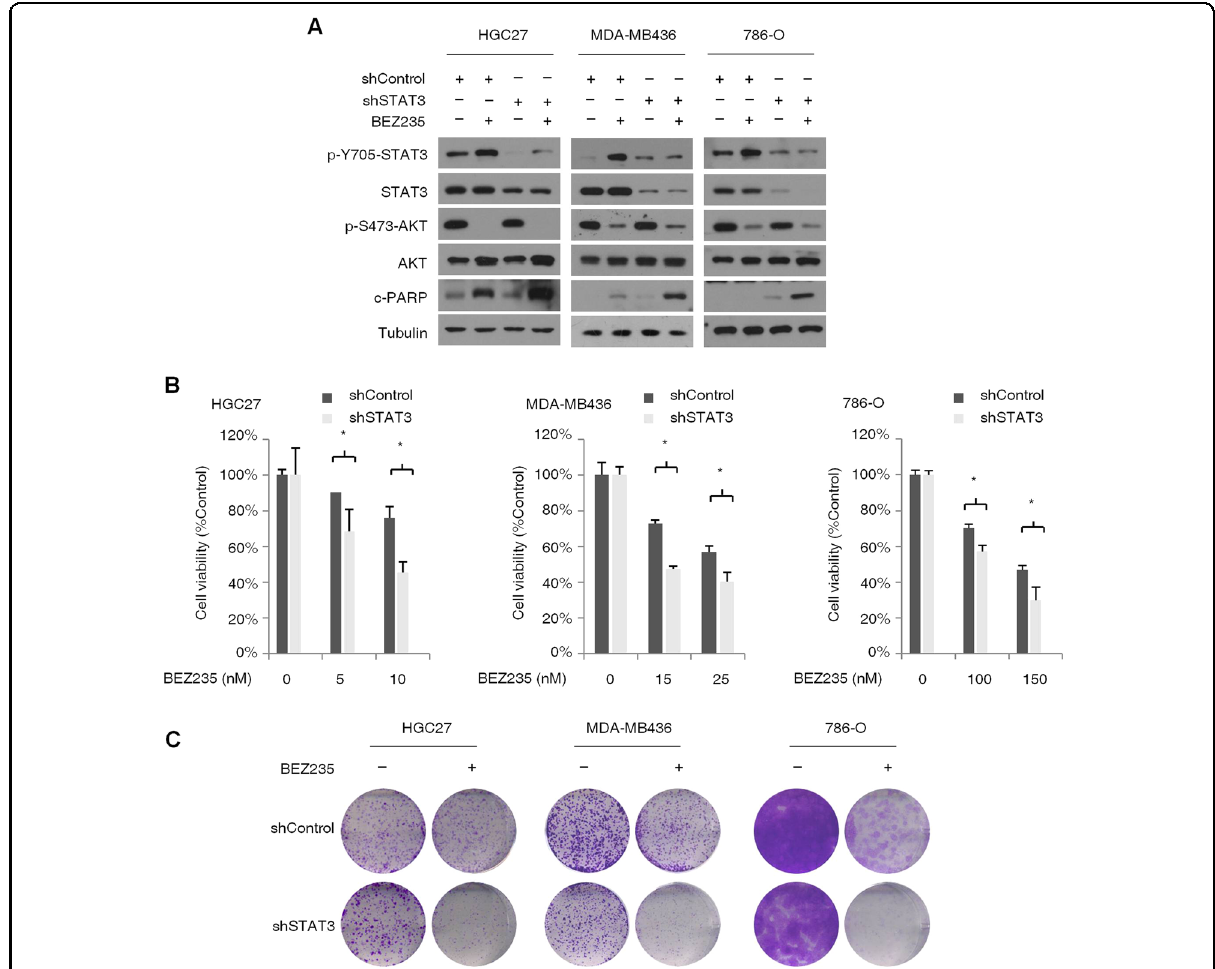
Fig. 3 STAT3 activation attenuates the inhibitory effects of PI3K/mTOR inhibitor BEZ235 on PTEN-de fi cient cancer cells. A Immunoblot (left panel) showing expression levels of p-STAT3, T-STAT3, p-AKT, T-AKT, and cleaved-PARP (c-PARP) in the control and STAT3-knockdown HGC-27, MDA- MB-436, and 786-O cells treated with BEZ235 (100nM) for 24 h. B Percentage of viable control and STAT3-knockdown HGC-27, MDA-MB-436, and 786-O cells after treatment with different concentrations of BEZ235 for 72 h. Error bars represent the means ± SD of triplicates. * P < 0.05. C Representative pictures showing crystal violet-stained colonies formed by the control and STAT3-knockdown HGC-27, MDA-MB-436, and 786-O cells treated with the indicated concentrations of BEZ235 for 14